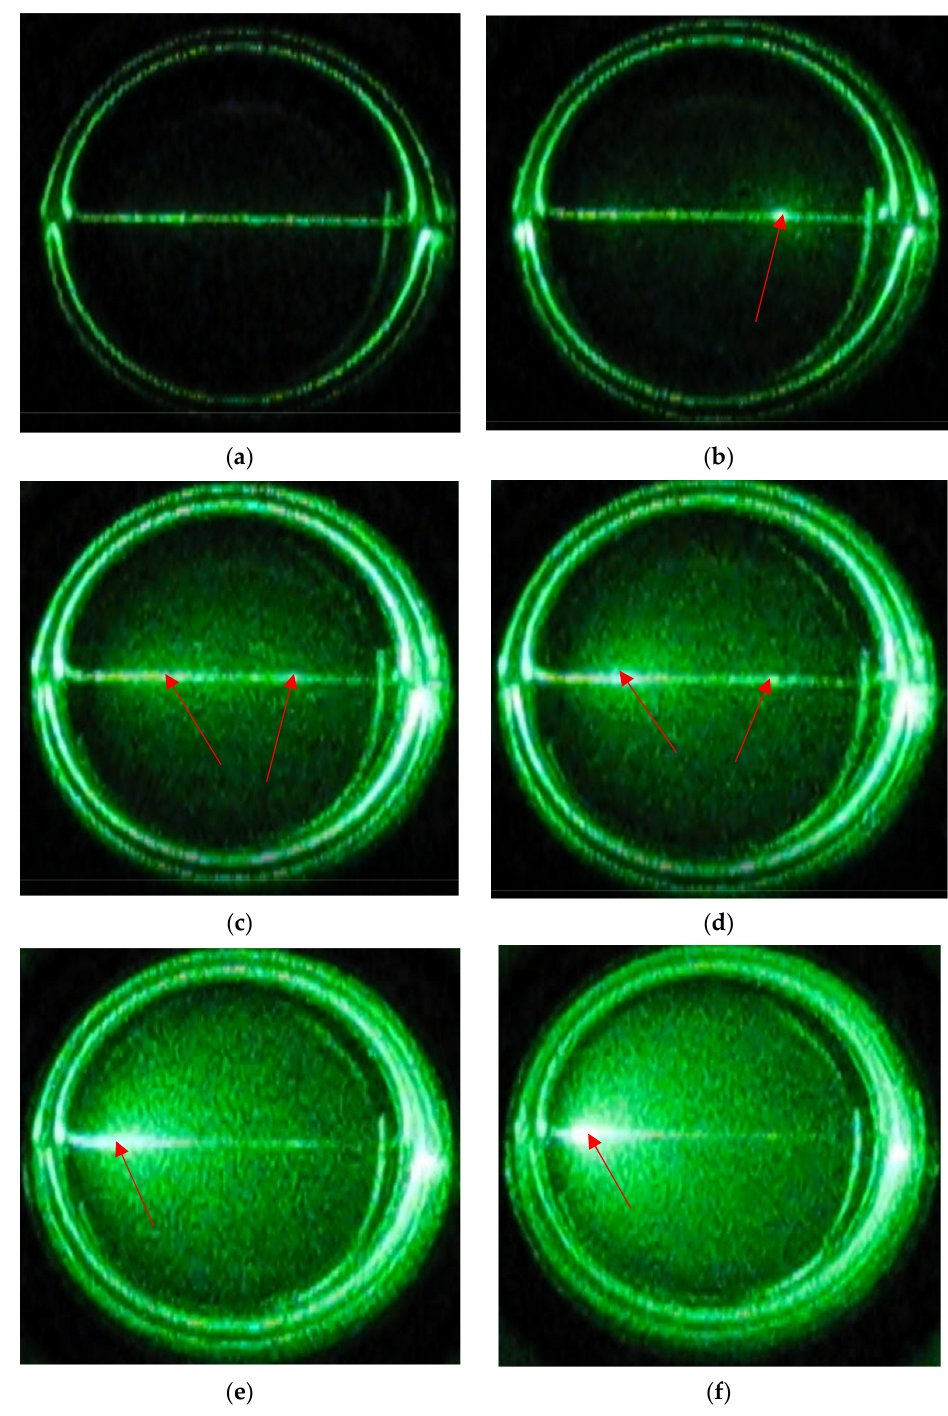
Figure 4. Sequence of images taken from a video recording of VIC-T polymerization and crosslinking of monomeric components under exposition to a laser light of 532 nm at 5 mW for 60 min; ( a ) is for 1 min of recording, ( b ) is for 6 min 50 s of recording, ( c ) is for 8 min of recording, ( d ) is for 8 min 35 s of recording, ( e ) is for 17 min 20 s of recording and ( f ) is for 55 min of recording. Arrows denote: green arrow in ( a )—incident green laser light beam (valid for each photograph); polymerization is induced along the laser beam light; however, red arrows indicate some clearly distinguishable spots where the intensity of light was higher and thus polymerization was more advanced. High intensity of scattered light shifts towards incident beam over time of exposure.